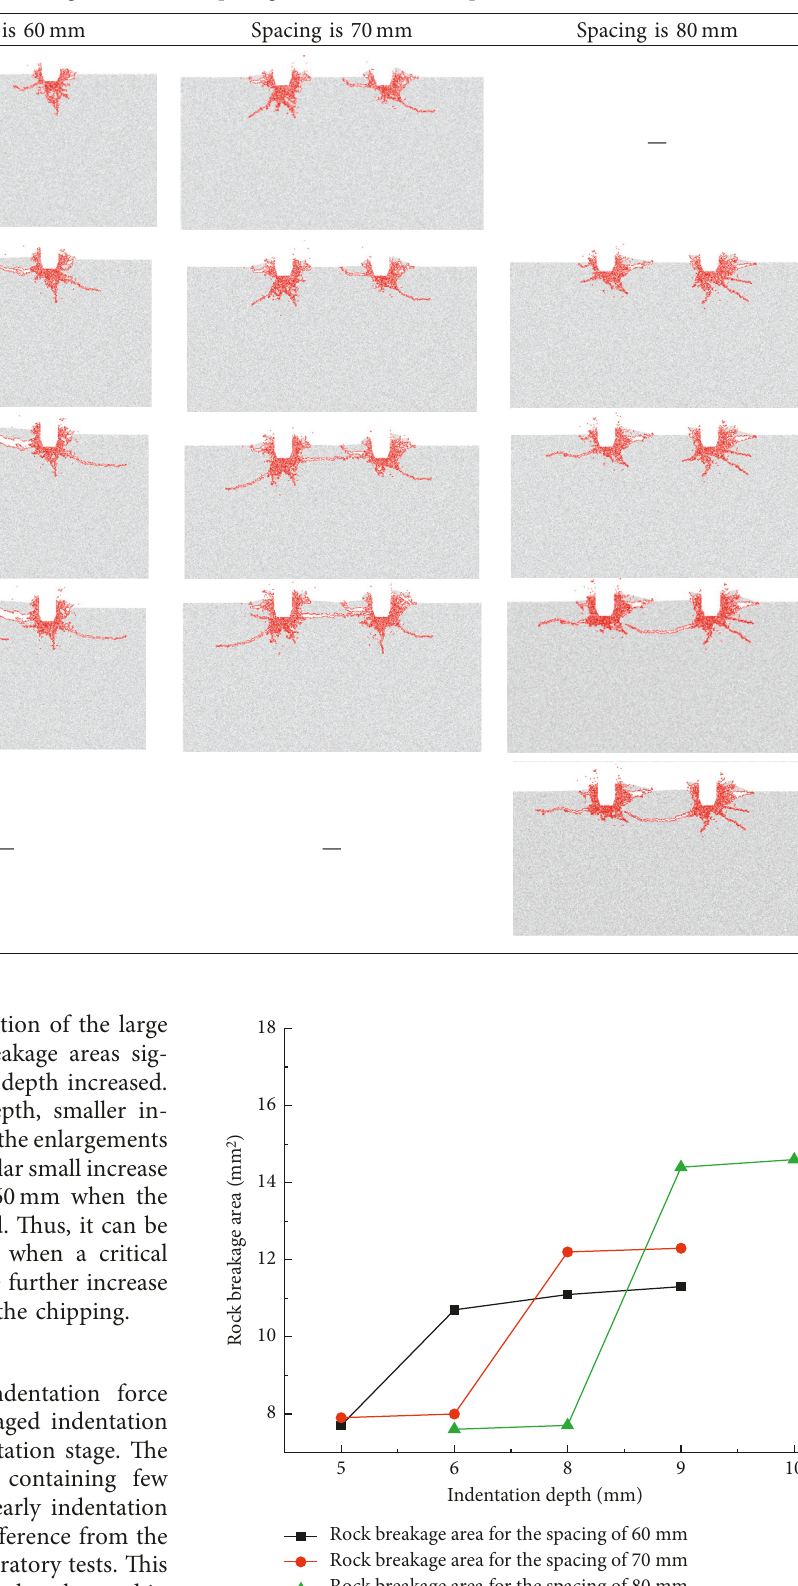
Figure 8: Measured rock breakage areas for various spacings and indentation depths.